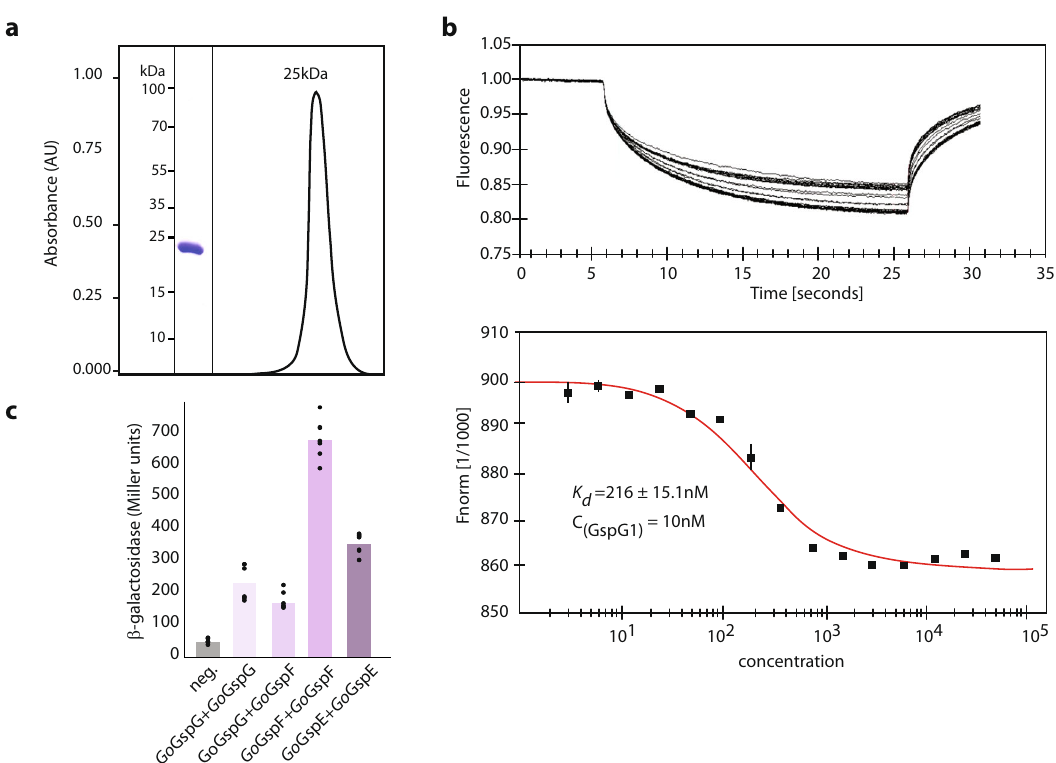
Fig. 7 The protein interactions of mitochondrial GspG. a The soluble part of the pseudopilin domain was puri fi ed to homogeneity on and ran through a gel fi ltration column, which demonstrated the stable monomeric state of the protein (representative image of three experiments is shown). b Thermophoresis of NT-647-labelled protein showed speci fi c self-interaction of the domain (top); plotting of the change in thermophoresis yielded a K d of 216 ± 15.1 nm, concentration of the labelled GspG was 10 nM (bottom), The error bars depict standard deviation; n = 3. c Positive interaction between the mitochondrial GspG protein and other mitochondrial T2SS subunits as determined by the BACTH assay, n =